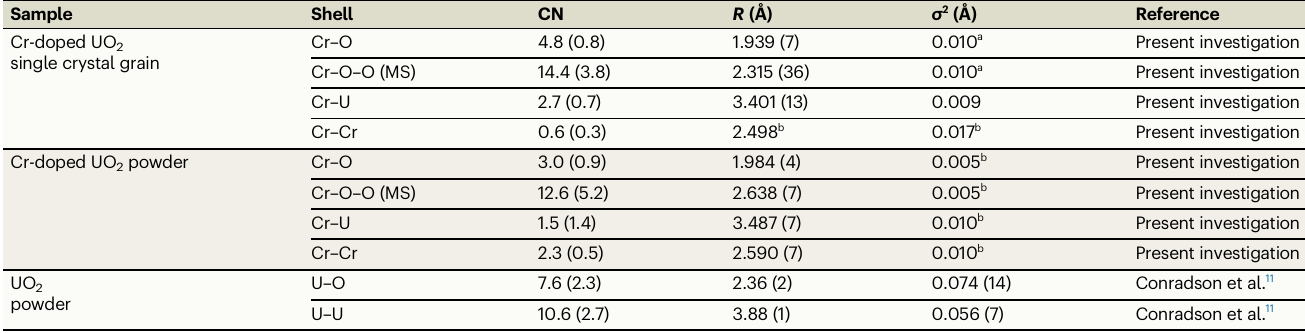
Table 1 | EXAFS fi t parameters for Cr K-edge data measured from Cr-doped UO 2 powder and single crystal grain in addition to reference U L 3 -edge EXAFS fi t data from Conradson et al. 11 for UO